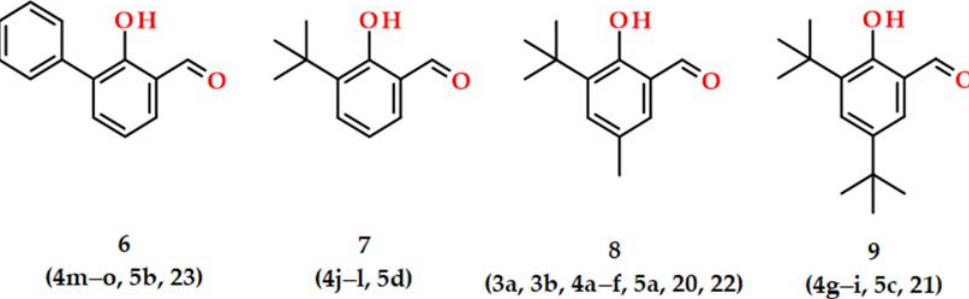
Figure 3. The structure of the aldehydes 6 – 9 used in the synthesis of corresponding target salicylic hydrazide-hydrazones 3 – 5 and 20 – 23 control compounds (enumerated in